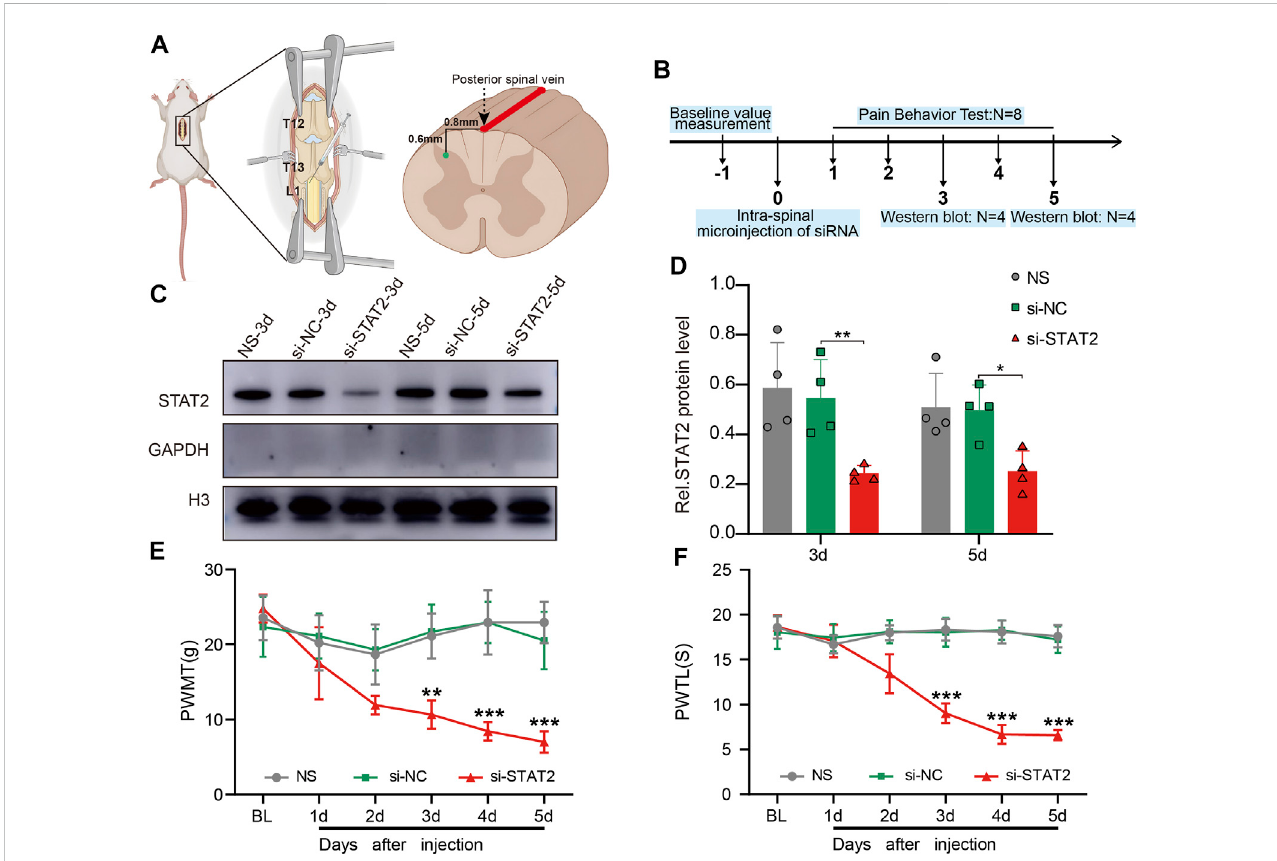
FIGURE 4 DownregulationofSTAT2inducednociceptivehypersensitivity. (A) Thespeci fi clocationoftheintraspinalinjectionofsi-STAT2. (B) Thetimepointsofsi- STAT2 administration in naïve rats. (C,D) Nuclear expression of STAT2 was reduced in the spinal dorsal horn (SDH) after si-STAT2 injection compared with thoseinratstreatedwithnormalsaline(NS)orthecorrespondingnegativecontrol(si-NC)( n =4,** p < .01,* p < .05,one-wayANOVAfollowedbyBonferroni ’ s multiple comparisons test). (E,F) Injection of si-STAT2 decreased the paw withdrawal mechanical threshold (PWMT) (E) and paw withdrawal thermal latency (PWTL) (F) in naïve rats from days 3 – 5 (si-STAT2 vs. si-NC, n = 8, ** p < .01, *** p < .001, two-way ANOVA with repeated measures followed by Bonferroni ’ s multiple comparisons